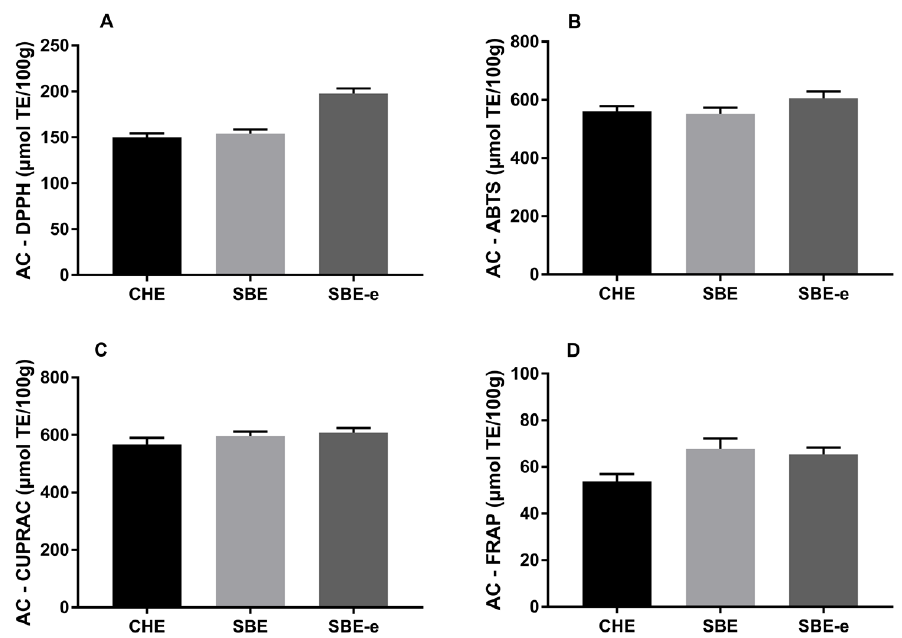
Figure 3. Antioxidant capacities (AC) of OBO extracted by different methods. A : DPPH for analyses of AC; B : ABTS for analyses of AC; C : CUPRAC for analyses of AC; D : FRAP for analyses of AC.